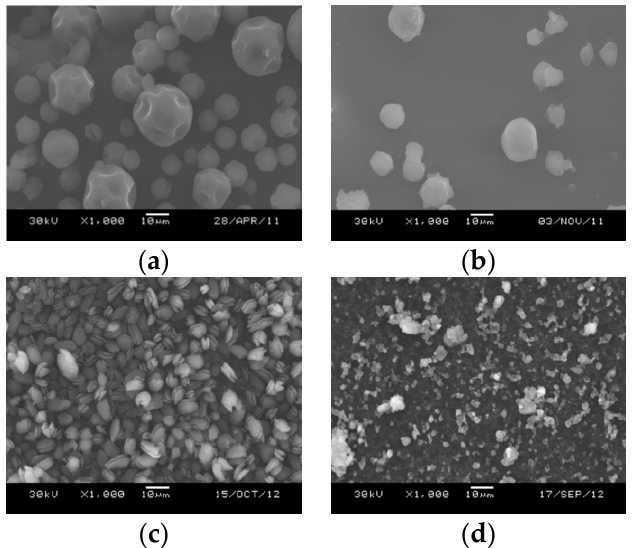
Figure 4. Morphology of the catalyst with different amounts of phthaloyl dichloride. (per 0.05 mol Mg): ( a ) 0.01 mol; ( b ) 0.005 mol; ( c ) 0.0025 mol; ( d ) 0